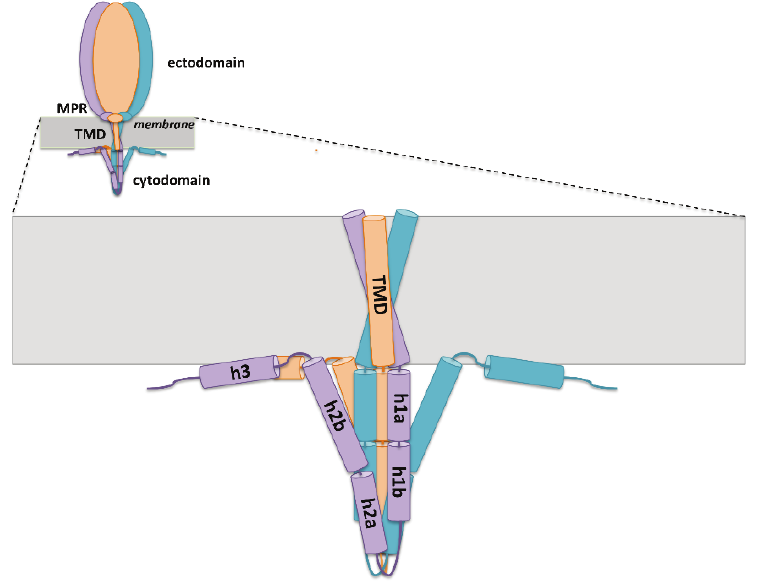
Figure 6. A model of the HSV-1 gB. Both the entire protein and a close-up view of the TMD and the CTD are shown. The ectodomain and the MPR regions are represented by ovals of different sizes. TMD helices are shown in a funnel configuration, one possible way in which they may be arranged. The CTD has a proteolytically resistant core and is predicted to contain three helices: h1, h2, and h3. These may be intact or interrupted by short linkers (as shown). Helices h2 and h3 are thought to interact with the membrane.